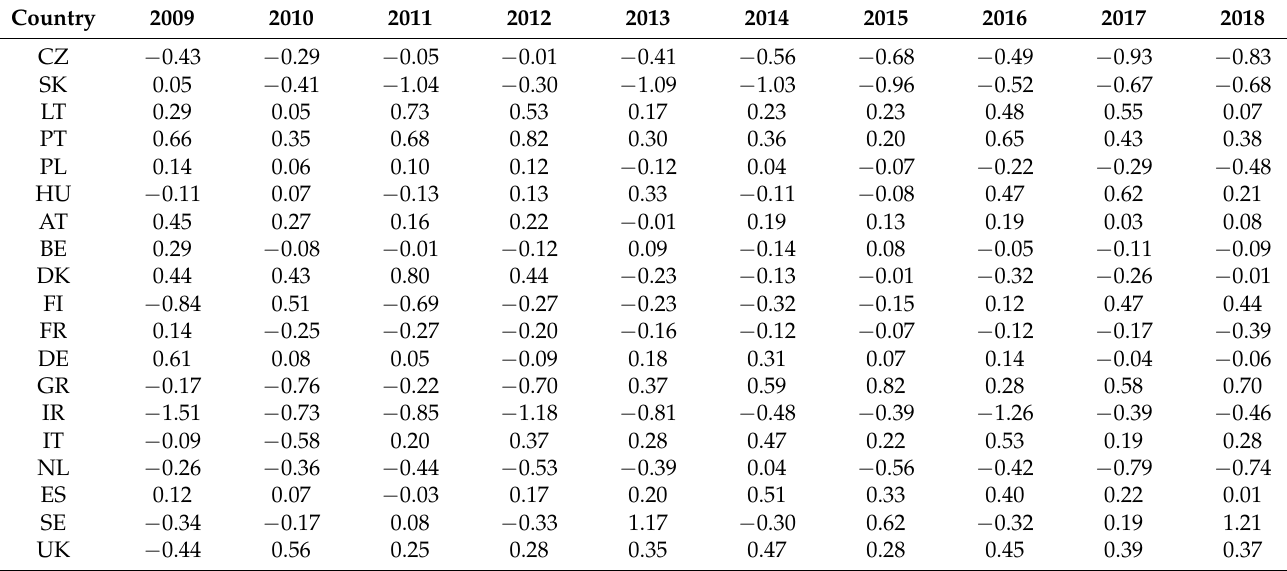
Table 2. EU basic metal industry (ISIC 24) competitiveness measure index, 2009–2018. Source: own processing.